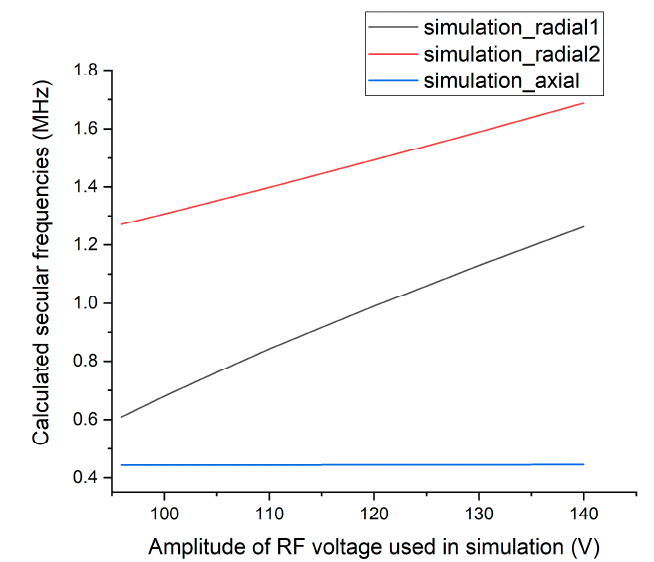
Figure 4. Expected secular frequencies of a 174 Yb + ion trapped by a total potential created by the RF voltage applied according to the numerical simulation. All the DC voltages remain constant as shown in Figure